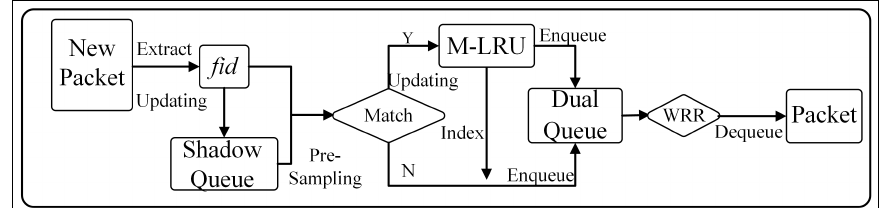
Figure 5. The SQM-LRU’s algorithm